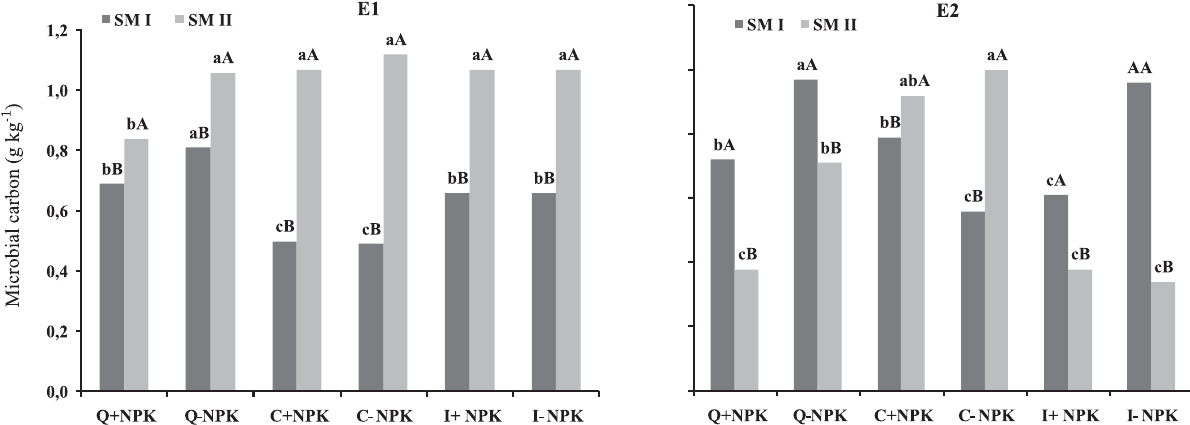
Figure 1. Microbial carbon in a Yellow Latosol, in the 0–0.1 m layer, under management systems in two seasons, rainy (S1) and dry (S2), S1, CV (%) = 6.9; S2, CV (%) =